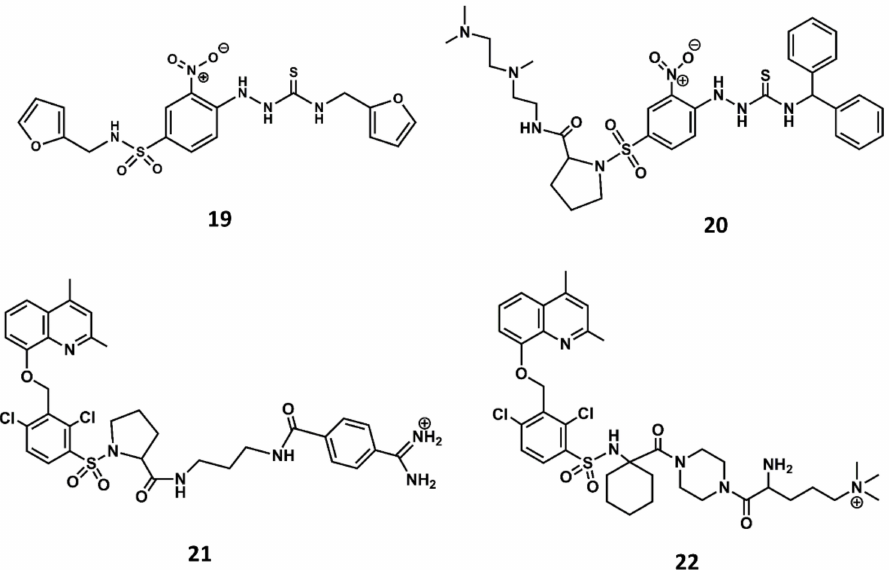
Figure 10. Chemical structures of diverse small molecule B2 antagonists: Novartis hit ( 19 ); Bradyzide ( 20 ); anatibant ( 21 ); fasitibant ( 22 ).